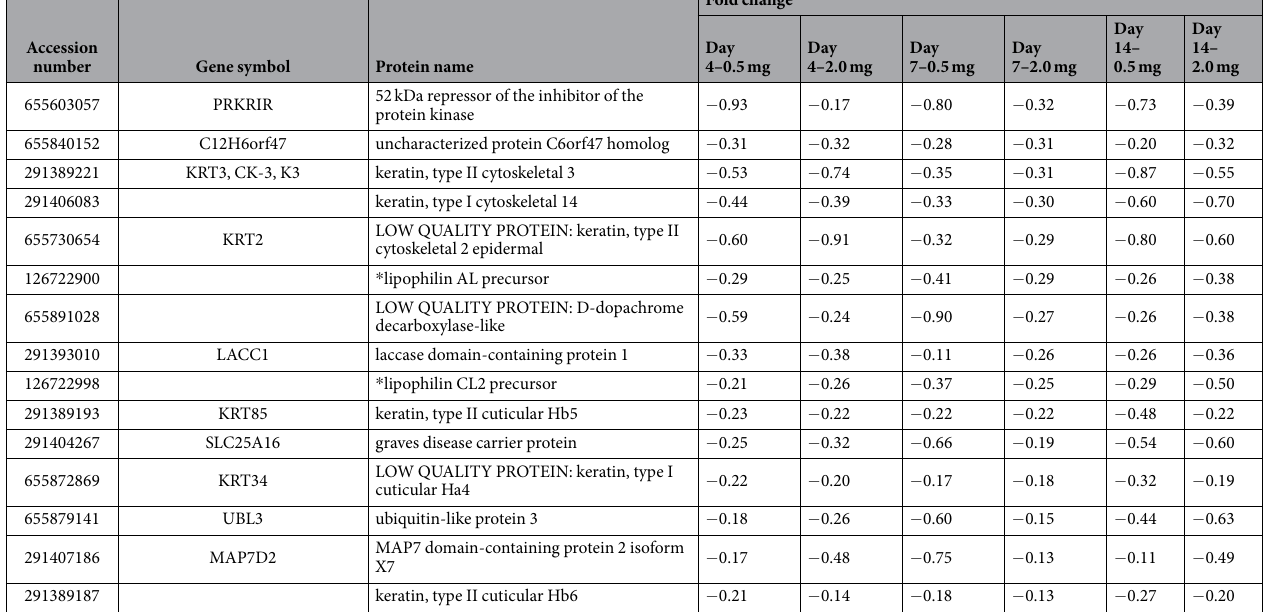
in anti-VEGF injected eye still provide important information with regard to the molecular changes in the retina. Based on these data, it is practical to confirm whether the proteins are actually altered and to explore their signif- icances. In addition, it is also possible to decide whether supplement treatments are necessary. For example, if it is confirmed that riboflavin kinase activity is lower in anti-VEGF injected eyes and consequently causes unwanted effect, it might be necessary to supply the patients with flavinmononucleotide. We concluded that intravitreal injection of high concentration and high frequency of conbercept is well tol- erated at least in a short-term in rabbit. Our study offers a comprehensive and intuitionistic overlook on the alteration of protein expression in the retina injected with conbercept. The data provided important information for the future clinical study and for designing therapeutic